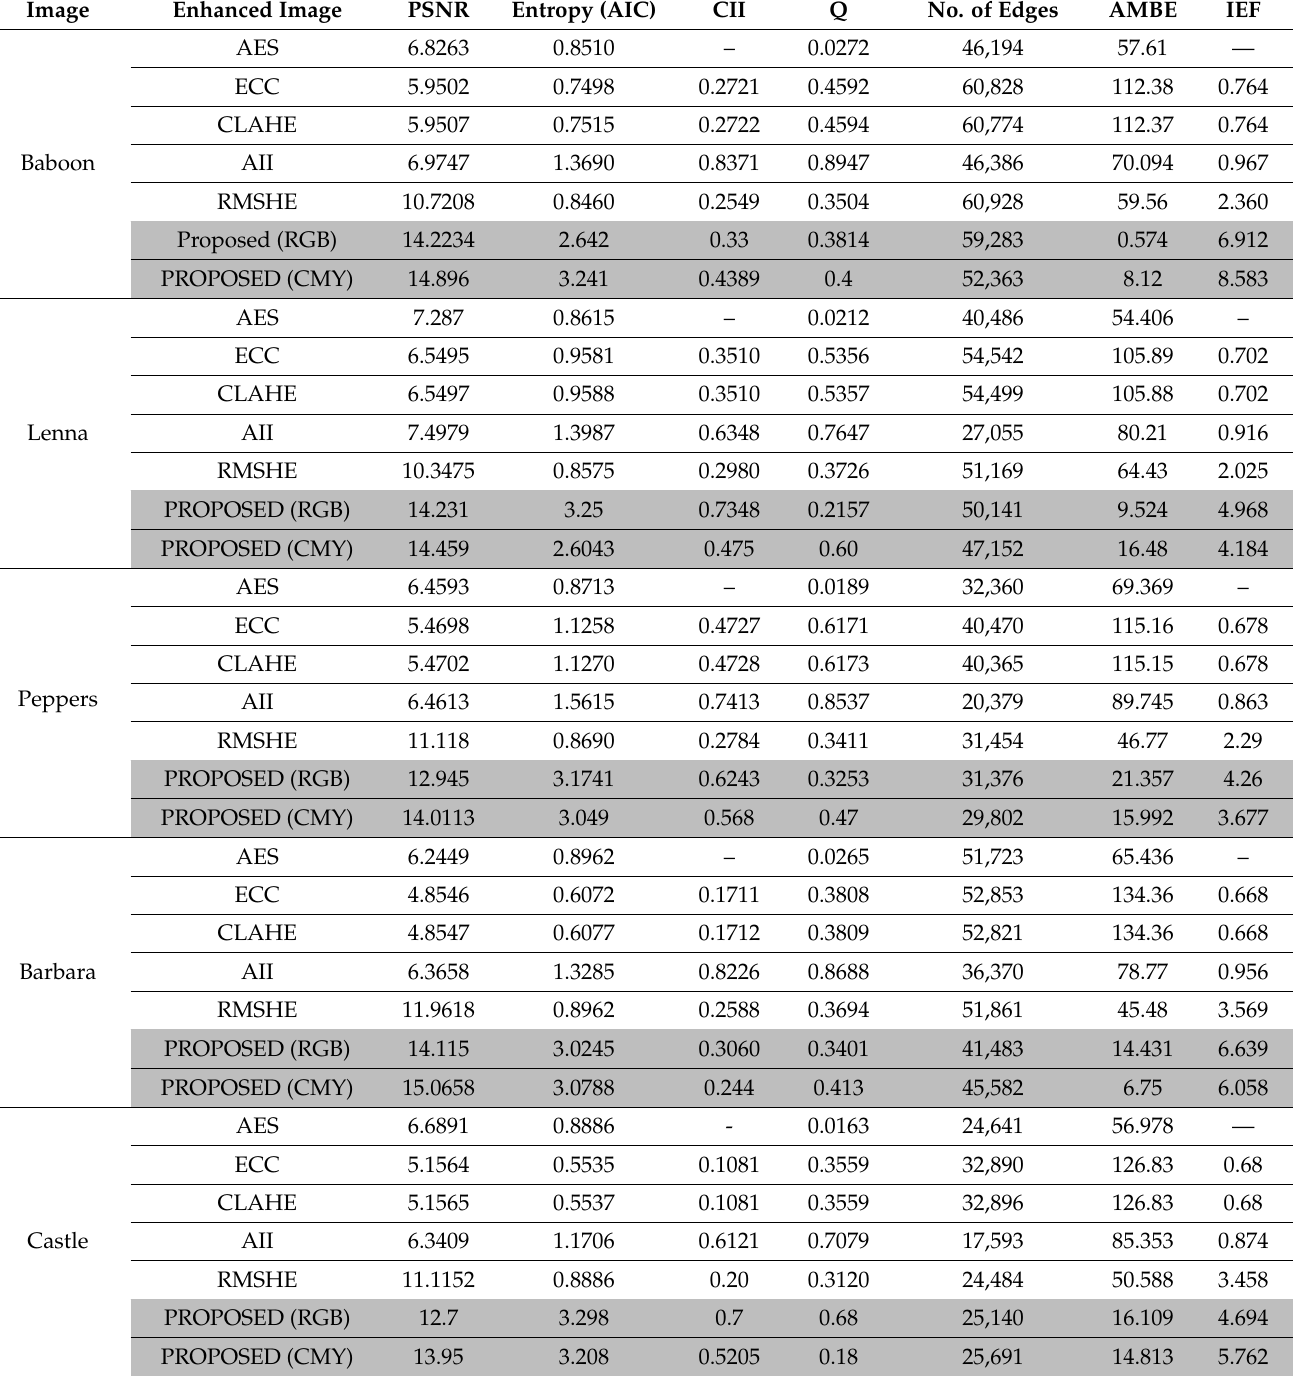
Table 4. Comparison of proposed work with Existing